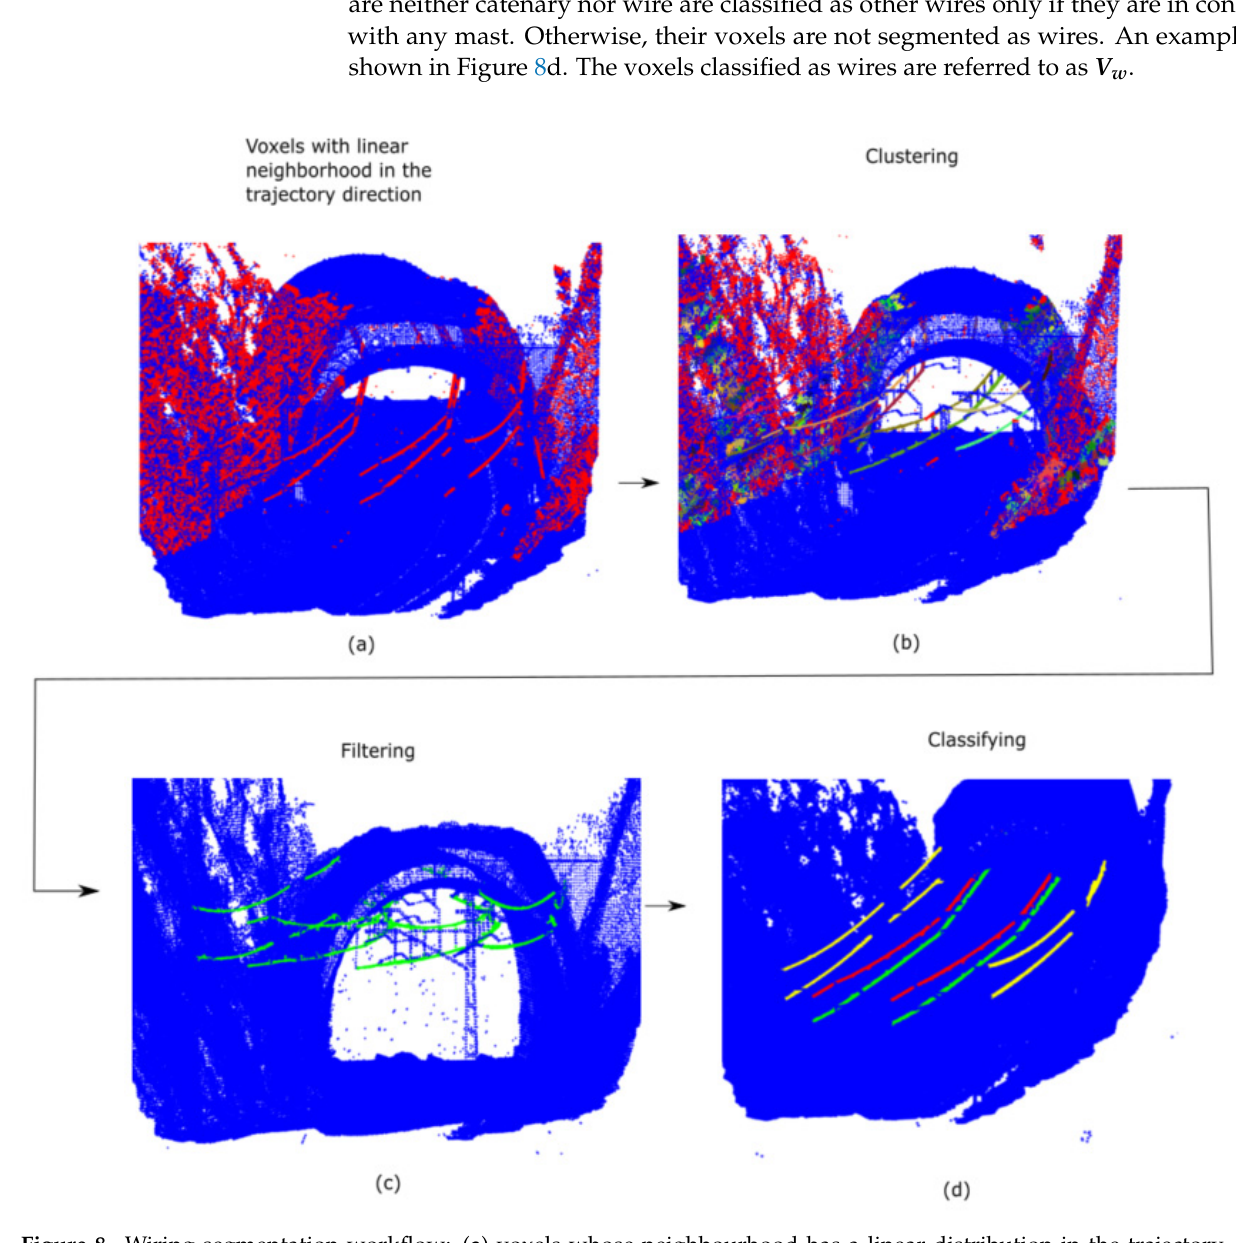
Figure 8. Wiring segmentation workflow: ( a ) voxels whose neighbourhood has a linear distribution in the trajectory direction; ( b ) clustered voxels, each cluster as a different colour; ( c ) remaining clusters once they are filtered by longitude, linearity, and density; ( d ) classified clusters. Contact wires are coloured in green, catenary wires in red, and other wires in